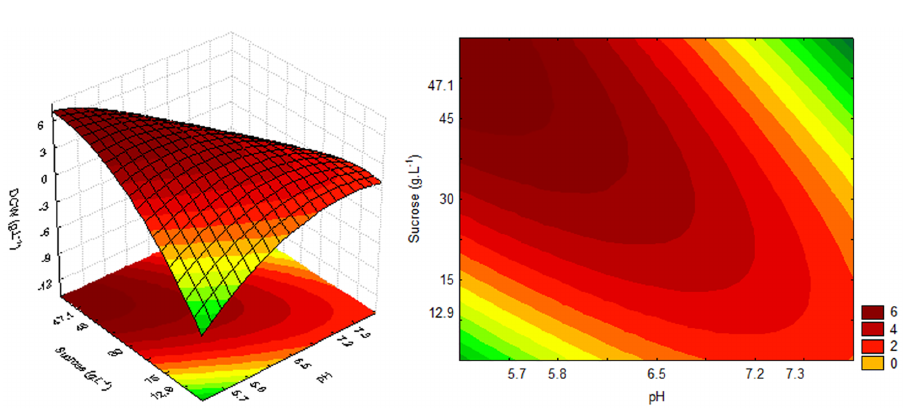
Fig 3. Response and contour surfacesas a function of sucrose concentration and pH for DCW.